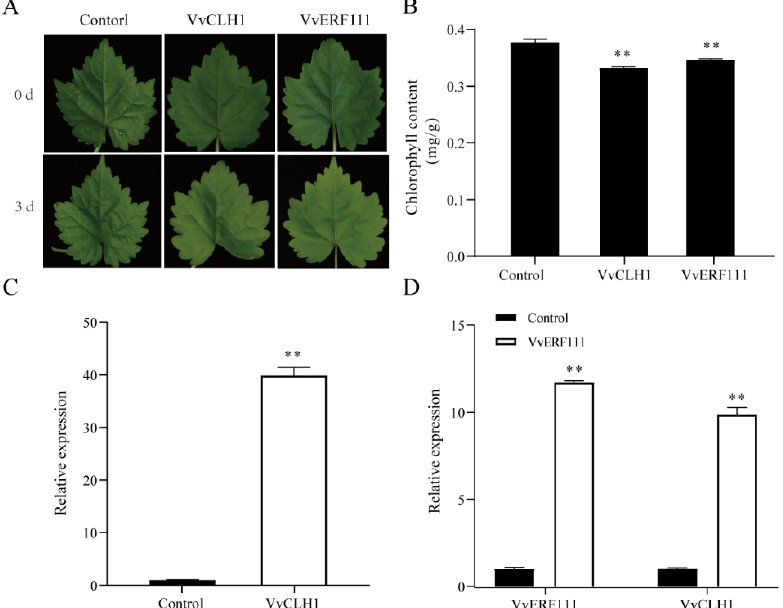
Figure 6. Transient overexpression of VvERF11 and VvCLH1 in grape leaves. ( A ) Color changes of grape leaves over-expressing VvERF111 and VvCLH1 . ( B ) Chlorophyll content in grape leaves after VvERF111 and VvCLH1 transient over-expression in grape leaves. ( C ) Expression of VvCLH1 in grape leaves with transient over-expression of VvCLH1 . ( D ) Expression of VvERF111 and VvCLH1 in grape leaves with transient over-expression of VvERF111 . Leaves transformed with 35S-GFP were used as control, data represented mean ± SE from three independent biological replicates, and ** represents significance at p < 0.01.